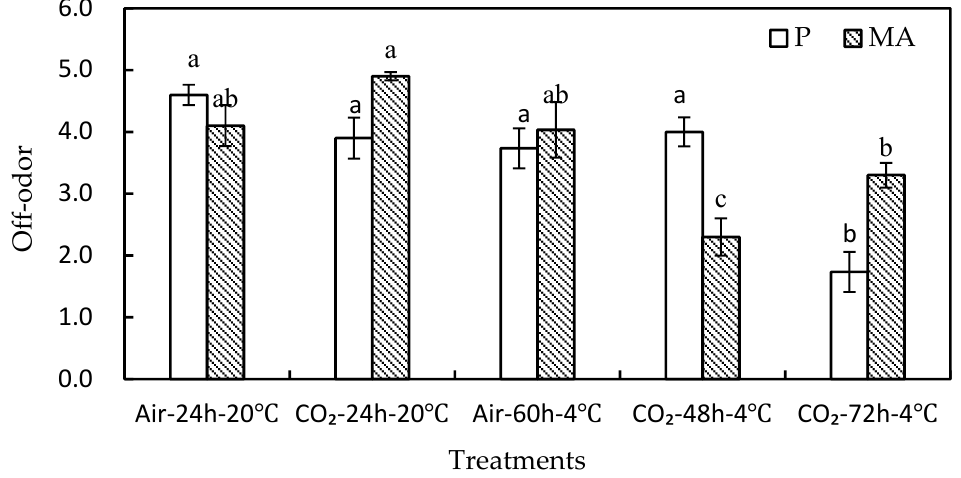
Figure 4. Off-odor of green asparagus in P and MA packages on the last storage day. Treatments of 60% CO 2 or air for 24 h at 20 °C and 60% CO 2 for 48 h, 72 h, or air treated for 60 h at 4 °C were conducted. All groups were stored at 4 °C until the final day. Values are presented as means ± SE ( n = 5). Different letters marked among the same packaging types indicate statistical difference using an LSD (Least Significant Difference) test at p < 0.05.